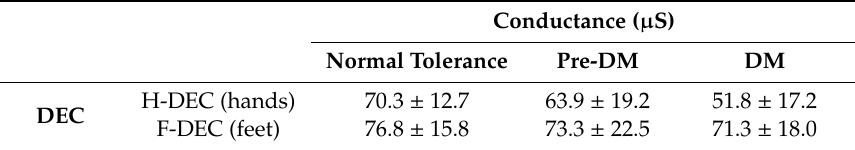
Table 4. Comparison between DEC results in the three groups of